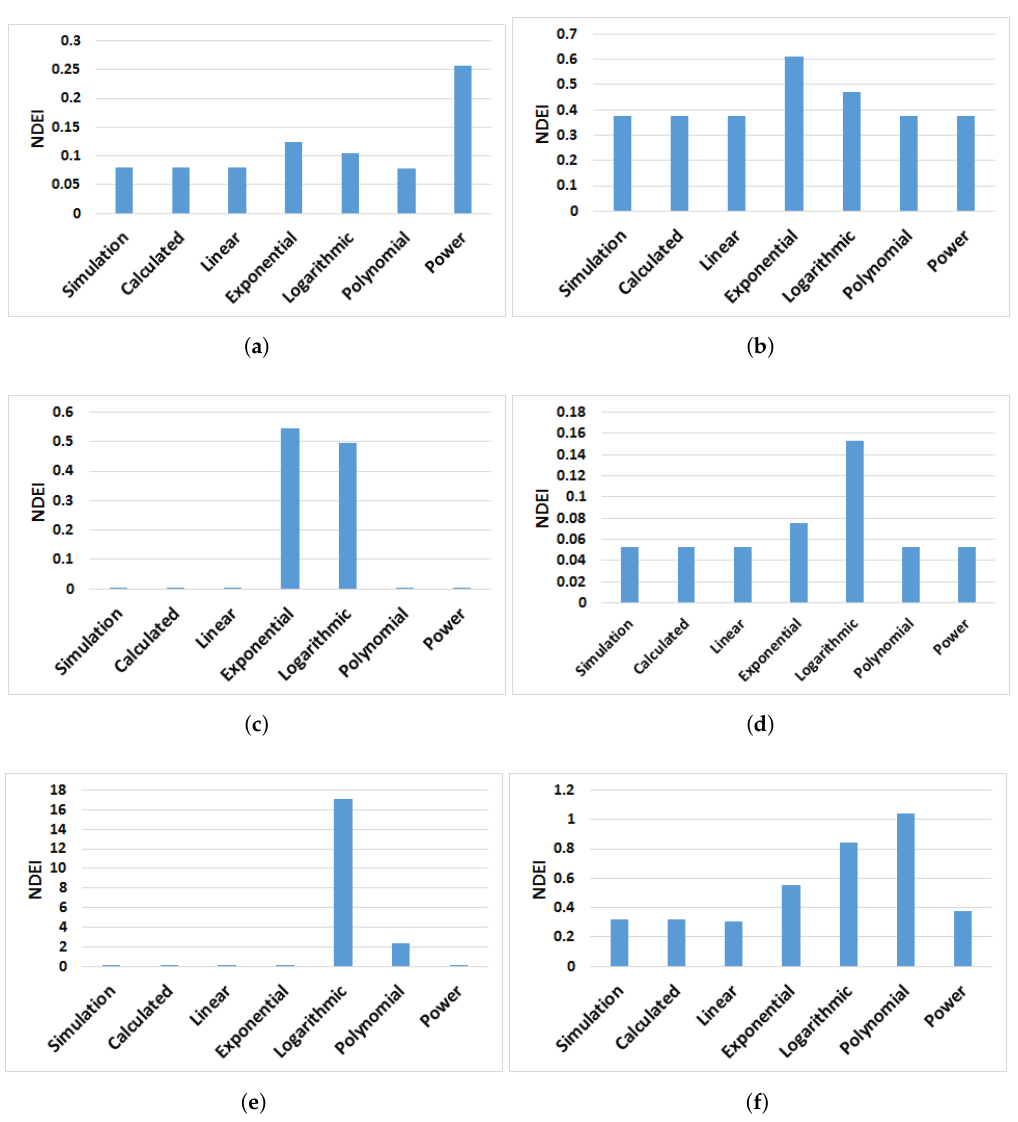
Figure A11. NDEI comparison between the results from simulation and analytically calculated values for steam (Area 1): ( a ) API; ( b ) depth; ( c ) permeability; ( d ) porosity; ( e ) saturation; and ( f )